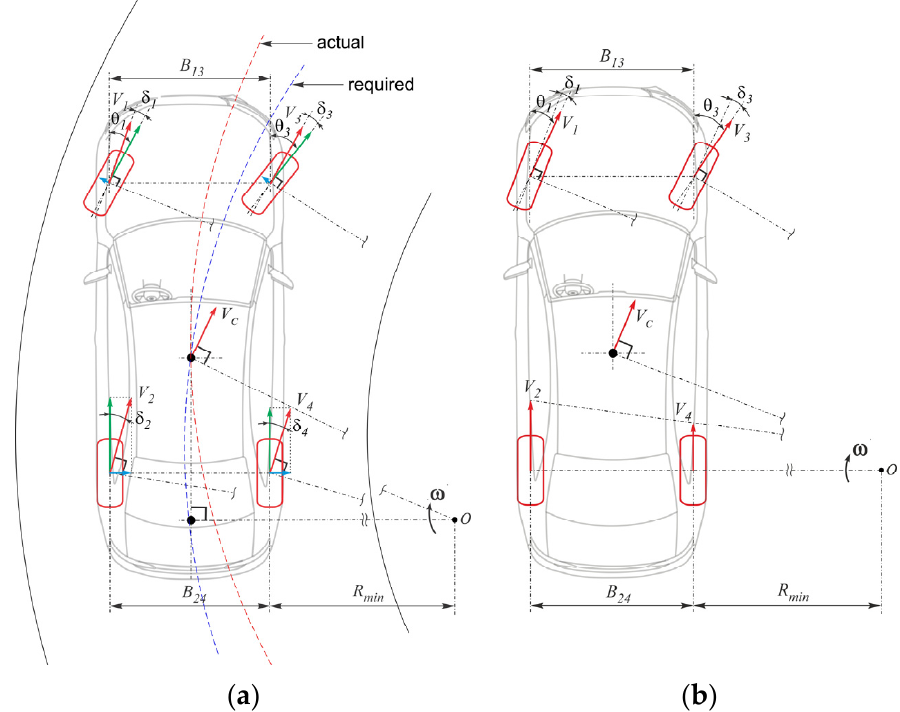
Figure 1. Steerability cases: ( a ) understeer and ( b ) neutral steer.